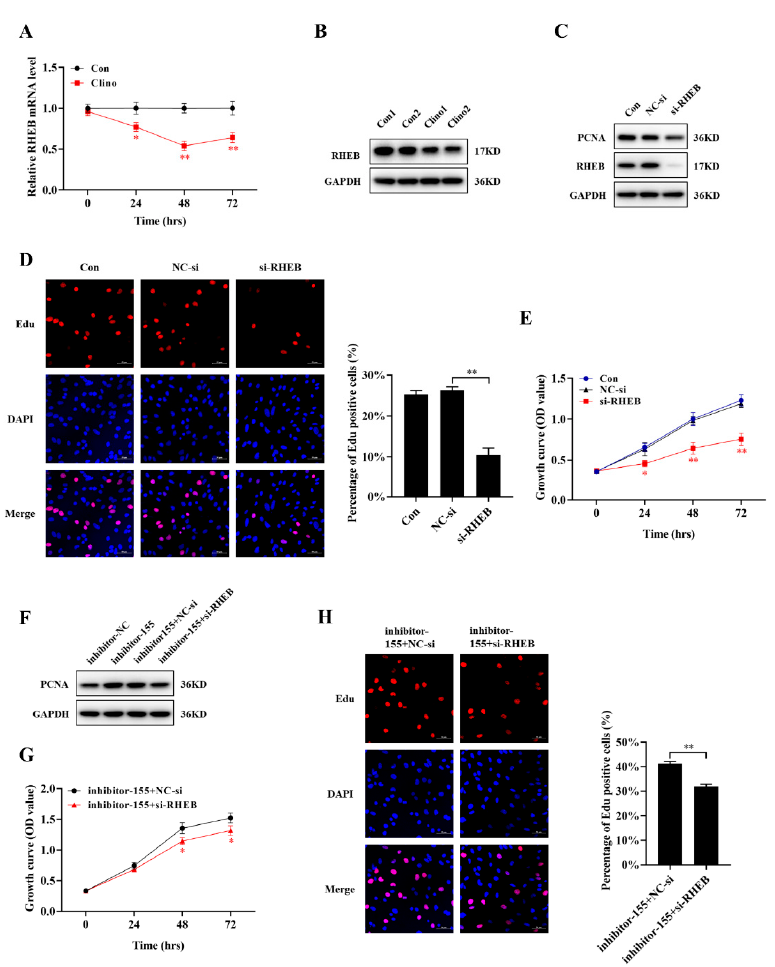
Figure 6. RHEB is downregulated under mechanical unloading and is essential for the miR-155-5p- mediated inhibition of microvascular endothelial cell proliferation. ( A ) RHEB mRNA expression was assessed in microvascular endothelial cells under clinorotation conditions for 24, 48 and 72 h (N = 3). ( B ) The RHEB protein level was analyzed by Western blotting (N = 3). ( C ) The RHEB and PCNA protein levels in microvascular endothelial cells were analyzed by Western blotting after transfection with RHEB siRNA (N = 3). ( D ) The EdU incorporation assay was analyzed by confocal microscopy (N = 3). ( E ) Cell proliferation was evaluated by CCK-8 assay (N = 3). The symbol *(Red) represents the NC-si group vs. si-RHEB group. ( F ) PCNA protein levels were measured by Western blotting after co-transfecting inhibitor-155-5p and siRNA-RHEB into microvascular endothelial cells (N = 3). ( G ) Cell proliferation was evaluated by CCK-8 assay at 24–72 h (N = 3). ( H ) The EdU incorporation assay was analyzed by confocal microscopy (N = 3). Scale bar, 50 µm. * p < 0.05, ** p < 0.01 vs. control. 2.7. HDAC6 Promotes Microvascular Endothelial Cell Proliferation by Inhibiting the mir-155- 5p/RHEB Axis